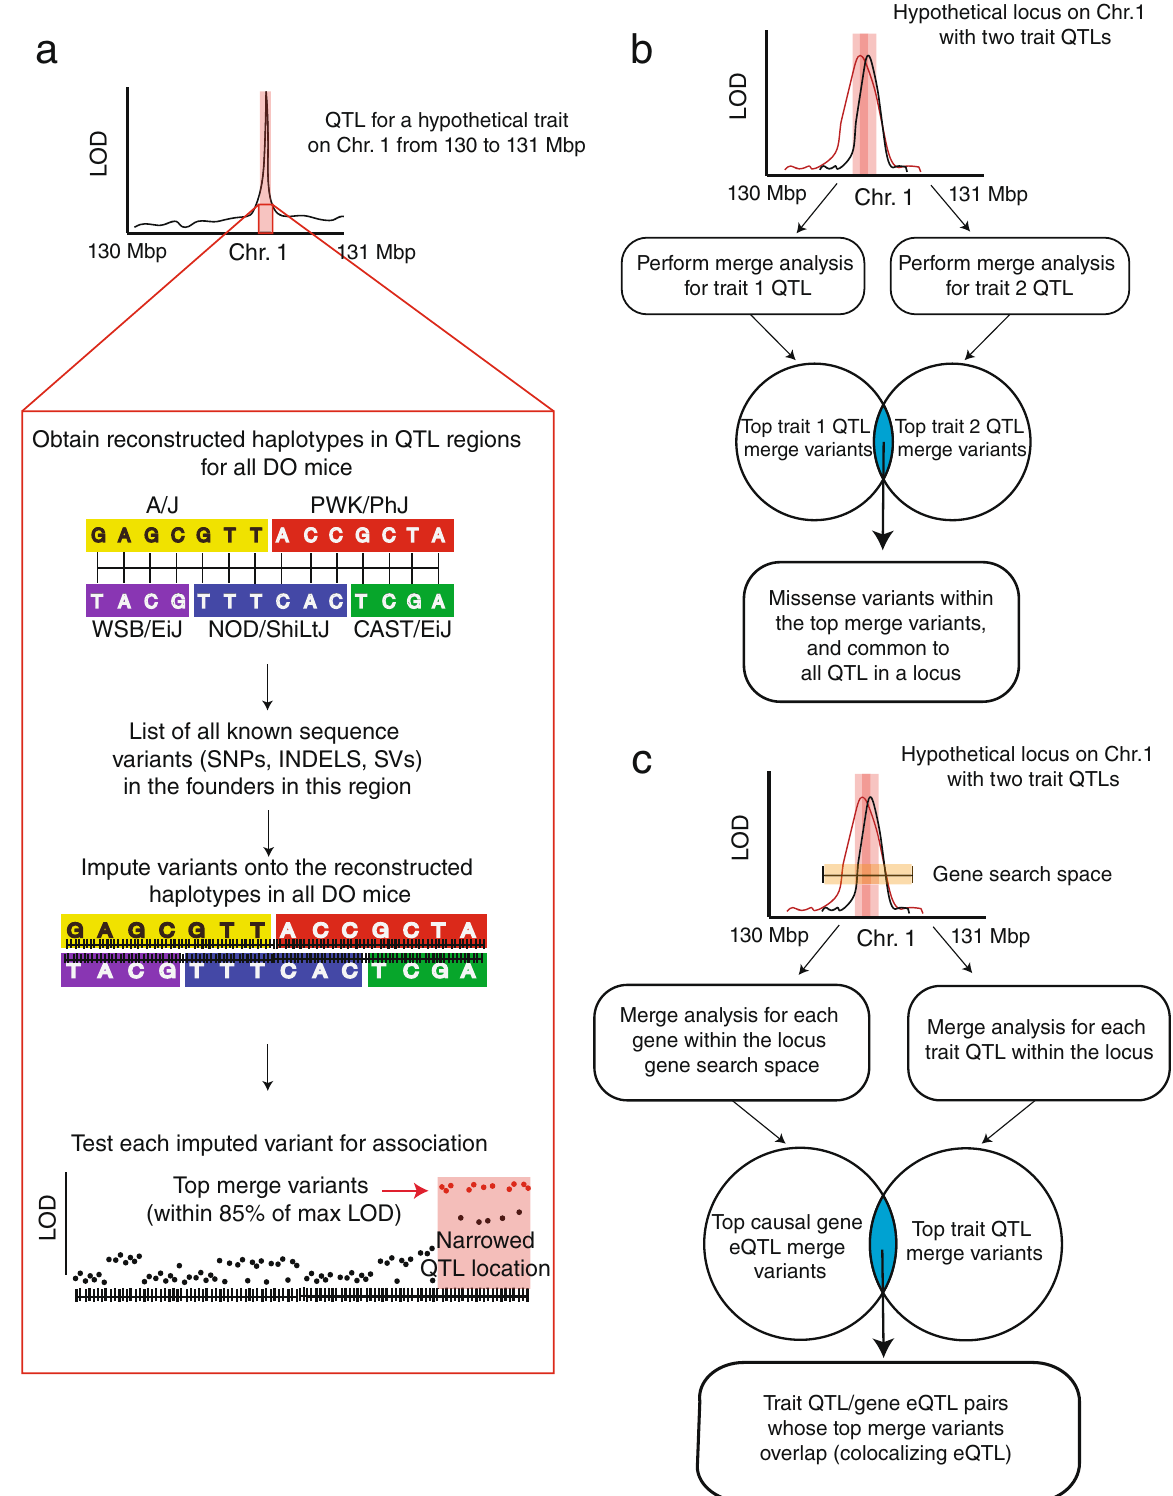
Fig. 5 Overview of our approach to QTL fi ne-mapping. a Overview of merge analysis. LOD logarithm of the odds, QTL quantitative trait loci, DO diversity outbred, SNP single-nucleotide polymorphism, INDEL insertion – deletion, SV structural variant. b Overview of merge analysis as performed for the identi fi cation of missense variants. c Overview of merge analysis as performed for the identi fi cation of colocalizing trait QTL/gene eQTL within a locus. The pink columns around the QTL in each association plot represent the QTL 95% con fi dence intervals. The yellow box in c represents the gene search space for a locus, de fi ned as the region within ±250 Kbp around the outer boundaries of the 95% con fi dence intervals within a locus. eQTL expression quantitative trait